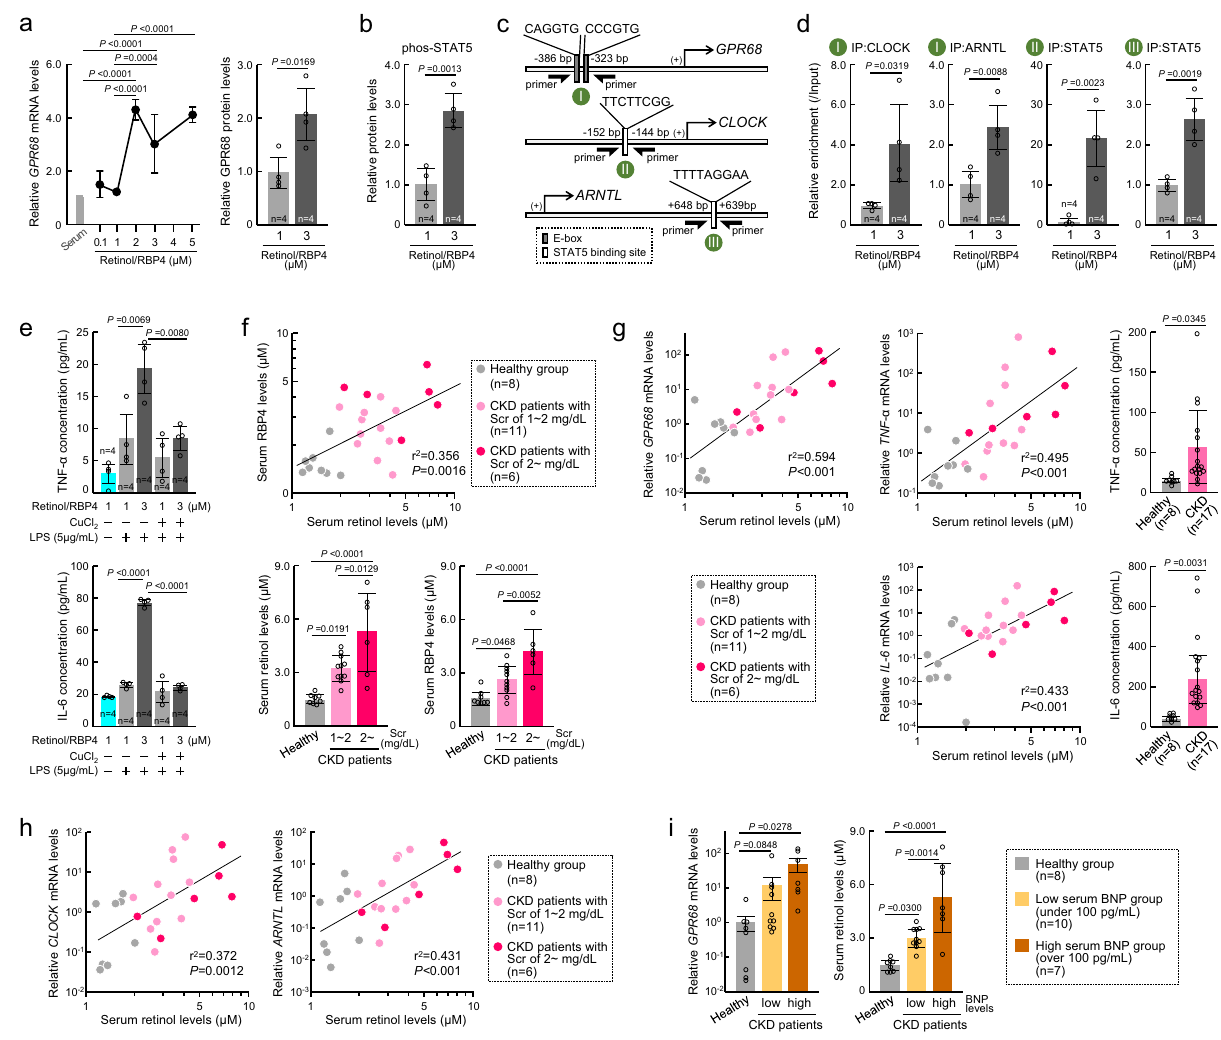
Fig. 8 Serum from CKD patients induces GPR68 expression in human monocytes. a Dose-dependent increase in the expression of GPR68 mRNA (left) and its protein (right) in human primary cultured monocytes by treatment with retinol/RBP4 for 24 h. b The phosphorylation state of STAT5 in human primary cultured monocytes after treatment with retinol/RBP4. c Schematic representation of the upstream region of the human GPR68 , CLOCK , and ARNTL genes. The circled letters (green circles) indicate the location on the gene where each of the different primer sets localize. d The binding of CLOCK, ARNTL, and STAT5 to regions, described in c , in human (healthy) primary cultured monocytes after treatment with retinol/RBP4 for 24 h. The primer sets used in qPCR are illustrated in c . e LPS-stimulated release of TNF α and IL-6 from human primary cultured monocytes after treatment with retinol/RBP4 for 24 h. f Serum retinol and RBP4 levels in CKD patients. The upper panel shows relationship between retinol and RBP4 levels. Lower panels show these levels strati fi ed by serum creatinine levels (Scr). g , h Relationship retinol levels to mRNA expressions of GPR68 , IL-6 , TNF α , CLOCK , or ARNTL in human primary cultured monocytes incubated in media containing 20% serum collected from healthy subjects and CKD patients strati fi ed by Scr. The release of TNF α and IL-6 from human primary cultured monocytes were assessed after incubation in the media containing 20% serum for 24 h. i Comparison of the values strati fi ed by BNP concentrations. Left panel shows the expression levels of GPR68 mRNA in human primary cultured monocytes incubated same as in g . Right panel shows serum retinol levels. For panel f – i , each plot shows a value obtained using an individual human serum. For all panels, graphs show the mean ± SD in independent experiments ( a , b , d , e n = 5 for each group, f – i shown in each graph). Statistical signi fi cance was determined using one-way ANOVA with Dunnett ’ s post hoc tests ( a ), two-tailed Student ’ s t -tests ( a , b , d , g ), or one-way ANOVA with Tukey – Kramer post hoc tests ( e , i ). Numbers and P -values are shown in each